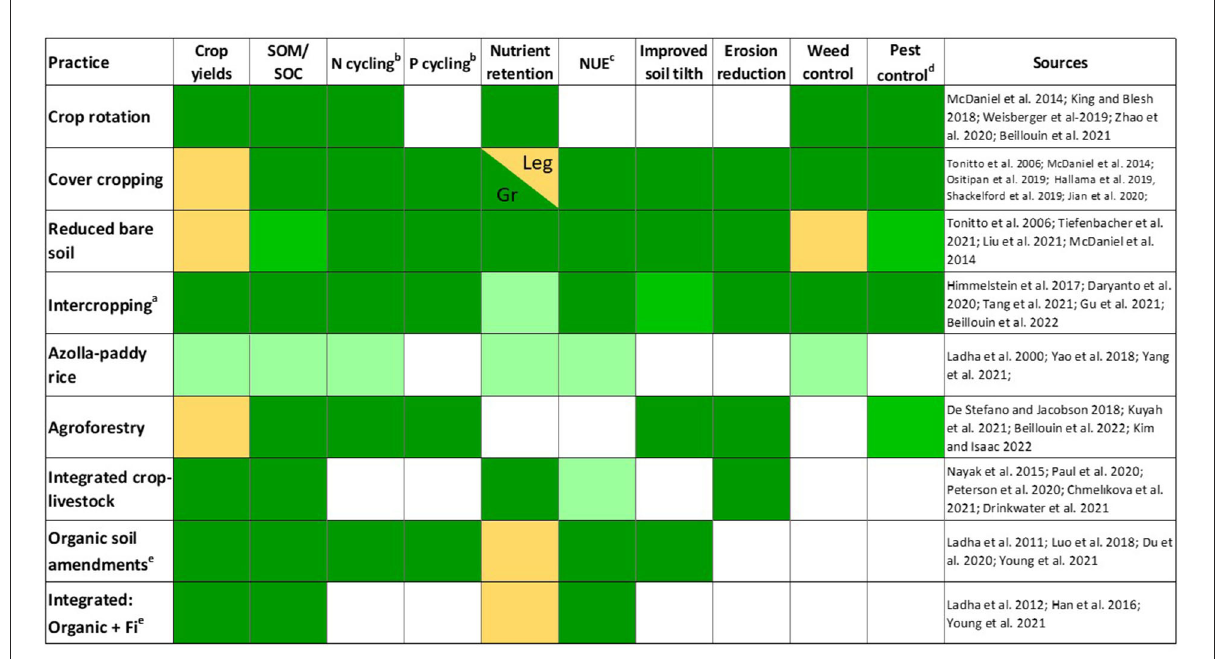
FIGURE5 ENM practices provide multiple ecosystem services. Management effects on desirable ecosystem services are indicated by color, with green indicating positive effects and orange indicating mixed or inconsistent effects. Dark green indicates the evidence is strong and reflects consistent results from multiple meta-analytical reviews while medium green indicates moderate evidence (i.e., ecosystem services that were considered in a limited number of meta-analyses). The lightest shade of green indicates limited evidence, including management effects where results are from the primary literature or a single meta-analysis. The split cell for cover cropping effects on nutrient retention indicates that the effect varies with cover crop composition; grasses (Gr) consistently increase nutrient retention while legumes (Leg) have inconsistent effects. Blank cells indicate ecosystem services for which there were insufficient data points to be included in the meta-analytical reviews. a Legume-grass intercrops dominate this literature; b Plant available and N org , P org ; c NUE = Nutrient use efficiency; d Pathogen and herbivore control; e Compared to Fi